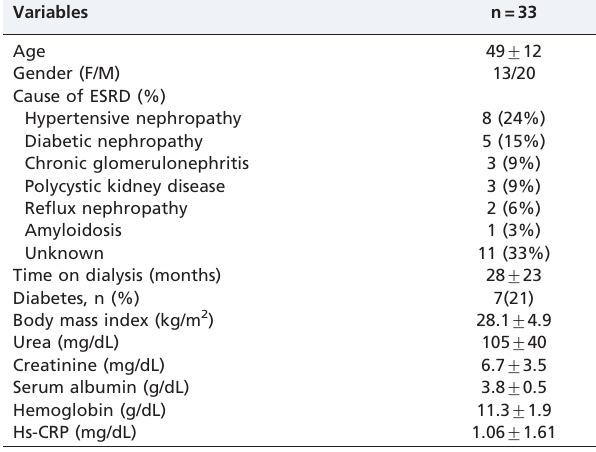
Table 1 - Demographic, clinical, and laboratory characteristics of 33 CAPD patients at study onset. Values are expressed as the mean ¡ SD, unless otherwise